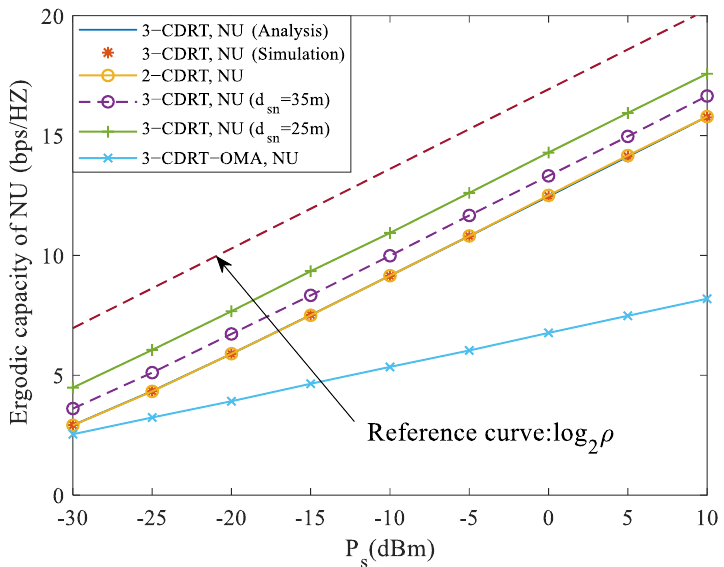
Figure 3. Comparison among the proposed 3 − CDRT strategy, the 2 − CDRT strategy and the 3 − CDRT − OMA strategy in terms of the ergodic capacity of NU with varying P s (dBm).